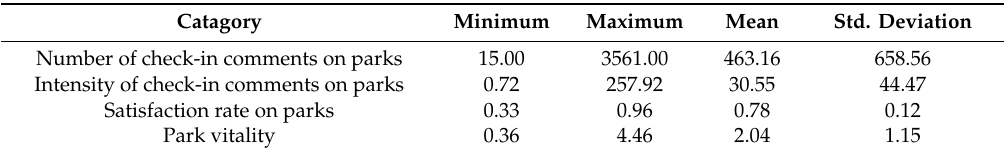
Figure 3. Spatial distribution of the total number of checked-in comments ( A ), the intensity of checked-in comments ( B ), recreational satisfaction rate ( C ), and the vitality ( D ) of urban parks in the study area. Table 3. Summary statistics of check-in comments, recreational satisfaction rate, and vitality of parks (N =